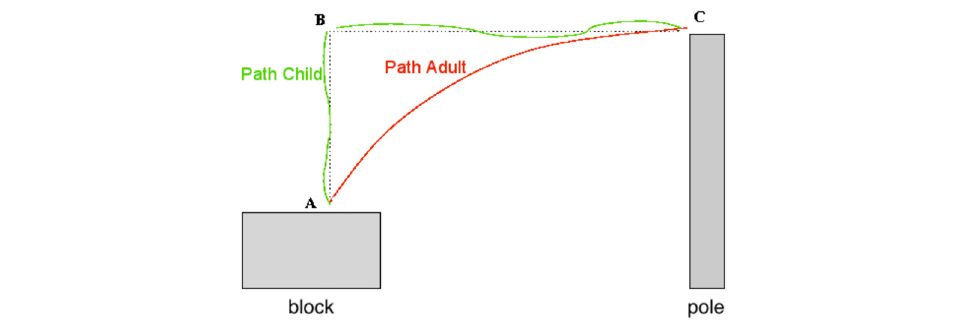
TABLE 1 The dependent measures—i.e., the parameters of action